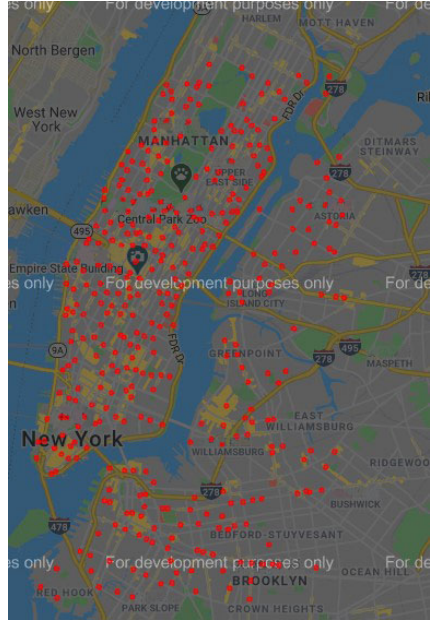
Figure 6. Virtual station distribution.